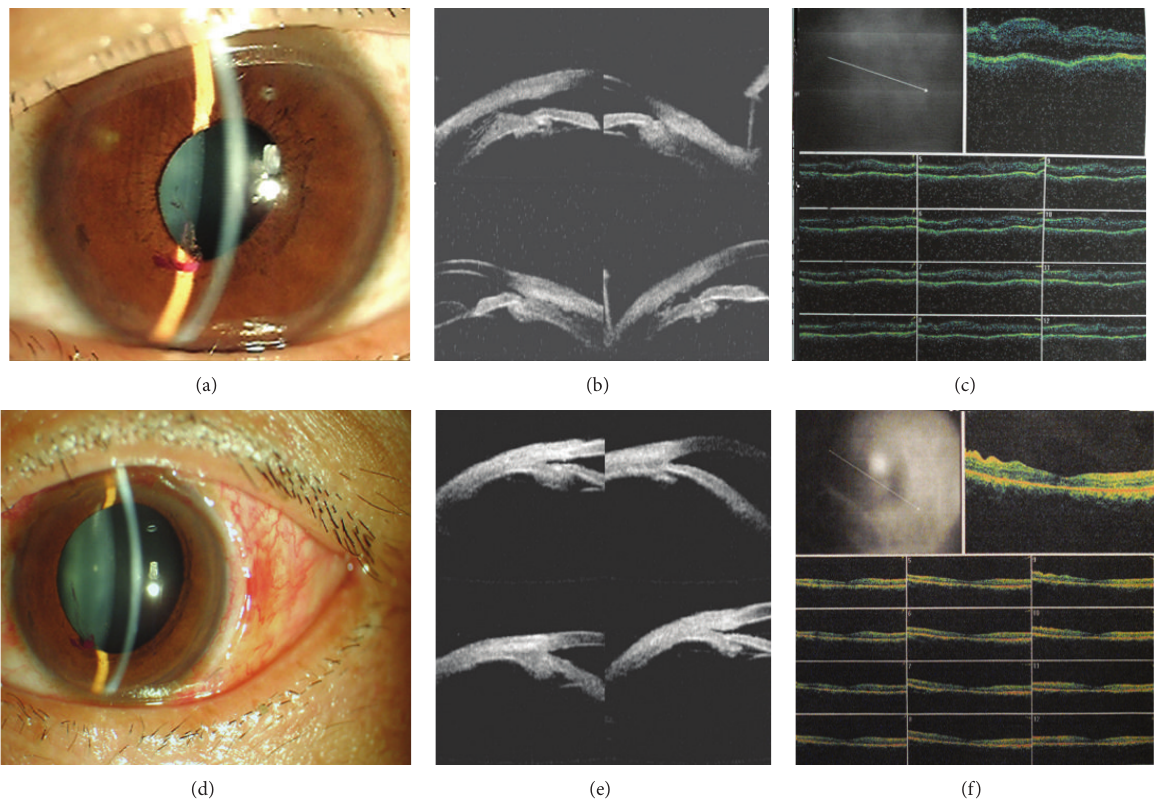
Figure 4: Anterior segment photography, UBM, and OCT in case 1. The top row represents the images before surgery. (a) A slightly shallow anterior chamber with vitreous prolapse. (b) A cleft and detached ciliochoroidal with suprachoroidal space effusion. (c) Retinal folds and macular edema. The bottom row is the images after surgery. (d) Recovery with a deeper anterior chamber and pharmaceutically dilated pupil. (e) Complete closure of the cyclodialysis cleft and the resolution of the ciliochoroidal detachment. (f) Presence of fovea centralis and reduced retinal